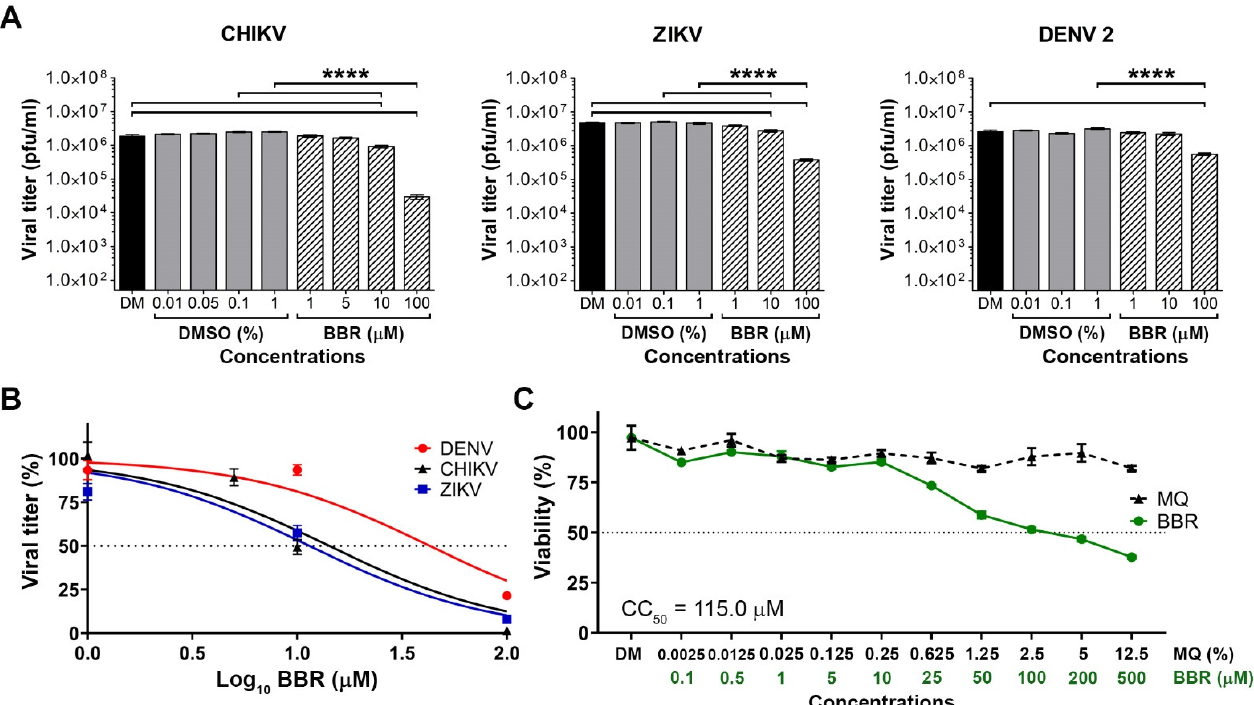
Figure 1. Direct effect of BBR towards viruses and cells. ( A ) Stock CHIKV, ZIKV and DENV 2 were treated with different concentrations of BBR or equivalent concentration of vehicle (DMSO) for 1 h before determining viral titer by plaque assay. Experiment was undertaken independently in triplicate with duplicate plaque assay. ( B ) Viral titers from ( A ) were used to determine IC 50 values. ( C ) BHK-21 cells were treated with different concentration of BBR or equivalent volume of MQ water in DMEM for 24 h before cell viability was determined by the MTT assay. Experiment was undertaken as 4 independent replicates. Errors bars show ± S.E.M. **** p ≤ 0.0001.